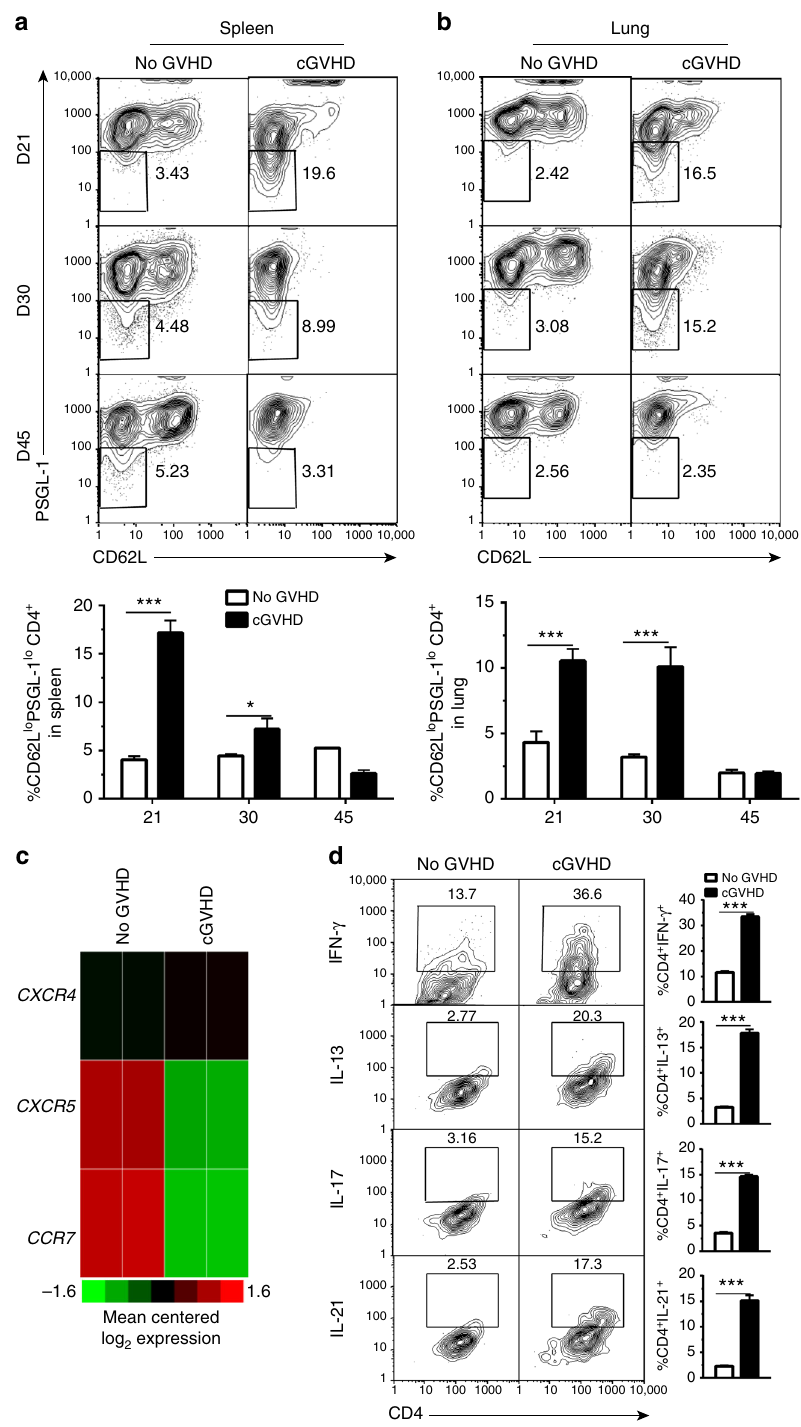
Fig. 3 cGVHD is associated with expansion of PSGL-1 lo CD4 + T cells. BALB/c recipients were irradiated (850 cGy) and given 2.5 × 10 6 TCD-BM or 2.5 × 10 6 TCD-BM plus 1 × 10 6 splenocytes from C57BL/6 donors. a , b Twenty-one, 30, and 45 days after HCT, spleen and lung were harvested. Splenocytes and mononuclear cells isolated from lung were stained for CD4, CD44, PSGL-1, and CD62L. Gated CD4 + CD44 hi are shown as PSGL-1 versus CD62L. PSGL-1 low and CD62L low cells were gated as extrafollicular CD4 + T cells. Percentages of PSGL-1 lo CD62L lo cells among CD4 + CD44 hi cells are shown as mean ± SE ( n = 8). c Twenty-one days after HCT, splenocytes from no-GVHD or cGVHD recipients given wild-type C57BL/6 transplants were harvested and stained for CD4, CD44, PSGL-1, and CD62L. CD44 hi CD62L lo PSGL-1 lo CD4 + T cells were sorted and used for RNA isolation and RNA-Seq microarray analysis. Heat maps of RNA expression of CXCR4, CXCR5, and CCR7 are shown as mean centered log 2 expression. RNA-Seq microarray measurements were performed on duplicate samples from no-GVHD group and cGVHD group. Each sample represents splenocytes from eight recipients. d Twenty-one days after HCT, sorted CD4 + CD44 hi PSGL-1 lo CD62L lo cells were stimulated with PMA and ionomycin for 24 h. Stimulated cells were stained and are shown as CD4 versus IFN- γ , IL-13, IL-17, or IL-21. Percentages of CD4 + IFN- γ + , CD4 + IL-13 + , CD4 + IL-17 + , or CD4 + IL-21 + cells among CD4 + T cells are shown as mean ± SE ( n = 9). * P < 0.05, *** P < 0.001, unpaired two-tailed Student ’ s t